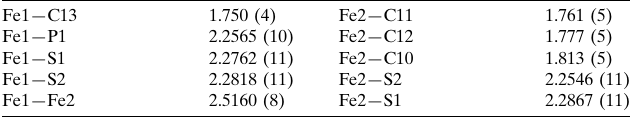
Selected bond lengths (A˚ ).